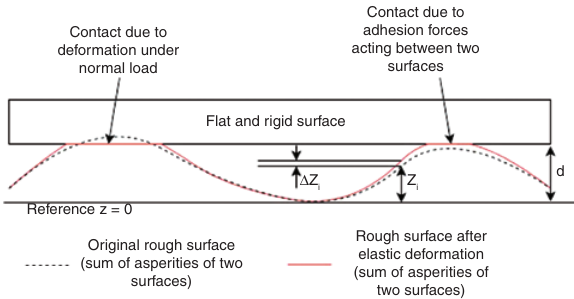
Figure 2: Schematic of contact between two real surfaces. Asperities of two real surfaces are merged into one surface called “rough surface”, and the second is presumed to be ideally “flat and rigid surface”. The figure shows deformation of the “rough surface” under load and due to adhesion forces.